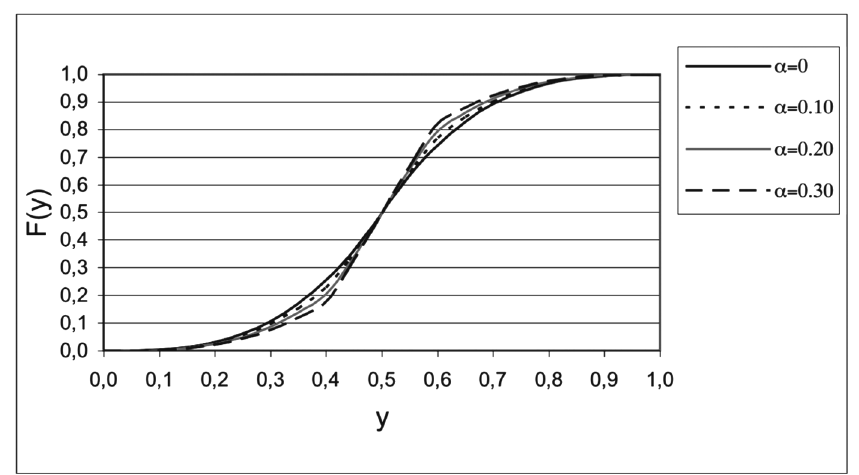
Figure 5 – Cumulative distribution function of MTSP ( α variable, β =0.20 ).